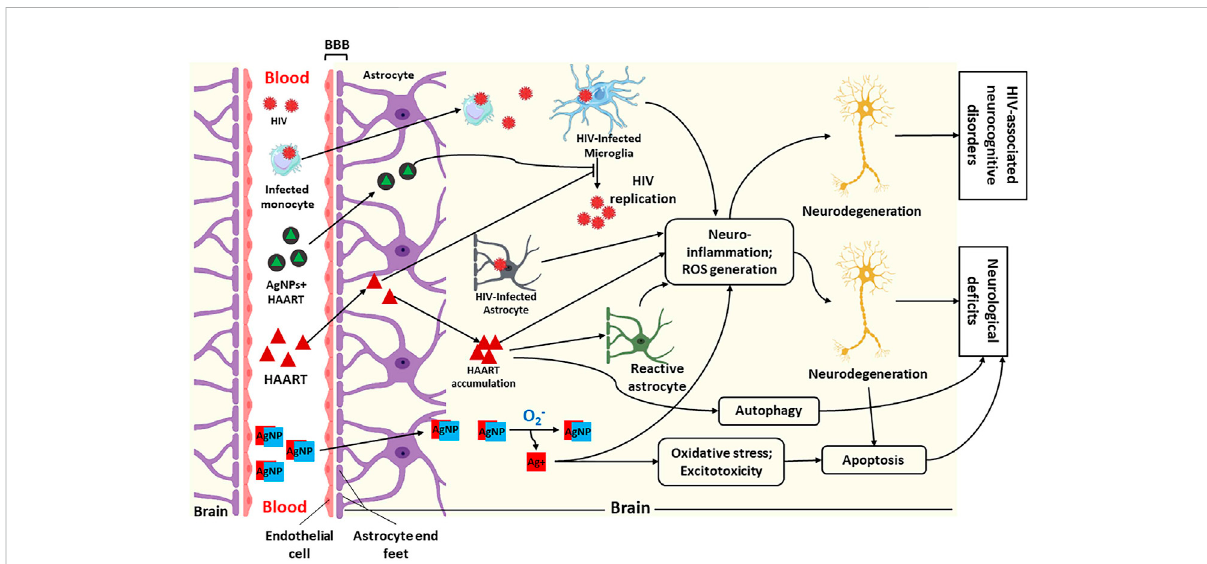
FIGURE 2 Illustration of penetration of silver nanoparticles (AgNPs), HIV and Highly Active Antiretroviral Therapy (HAART) + AgNPs (AgNPs + HAART) throughtheblood-brain barrier(BBB)and theirpossiblemechanism ofactionwithin thebrain. This fi gure shows thatHIVand infected macrophages traverse theBBB into thebrain interstitial spaceto infectmicroglia,leading to HIV replication.Furthermore, HAART and AgNPs + HAART traverse the BBBtoblockorinhibitHIVreplication.Lastly,AgNPsalonecanalsocrossBBBintothebrain.Withinthebrain,AgNPsgetoxidisedtoreleaseAg + . The infected microglia, astrocyte, and Ag + cause neuroin fl ammation and increased reactive oxygen species (ROS) generation, leading to neurodegeneration and HIV-associated neurocognitive disorders. While HAART inhibits HIV replication, it also causes neurodegeneration via neuroin fl ammation, ROS generation and autophagy. On the contrary, AgNPs + HAART show a better output by preventing HIV replication with reduced neurocognitive disorders. Adapted from (Lawal et al., 2022a; Lawal et al., 2021; Lawal et al., 2022b).